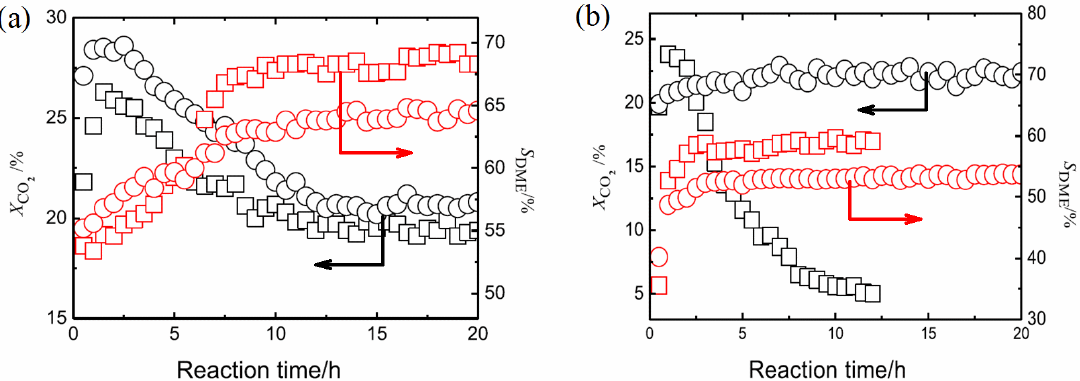
Figure 7. CO 2 conversion ( X CO2 ) and selectivity of dimethyl ether ( S DME ) with (square) and without (circle) H 2 S in the gas feed. ( a ) CaO–CeO 2 –Pd/HZSM-5; ( b ) Cu–ZnO–Al 2 O 3 /HZSM-5. Conditions: 250 °C, 3 MPa, 1600 mL·g − 1 ·h − 1 , H 2 /CO 2 = 4.4. Reproduced with permission from Chu et al. [93],